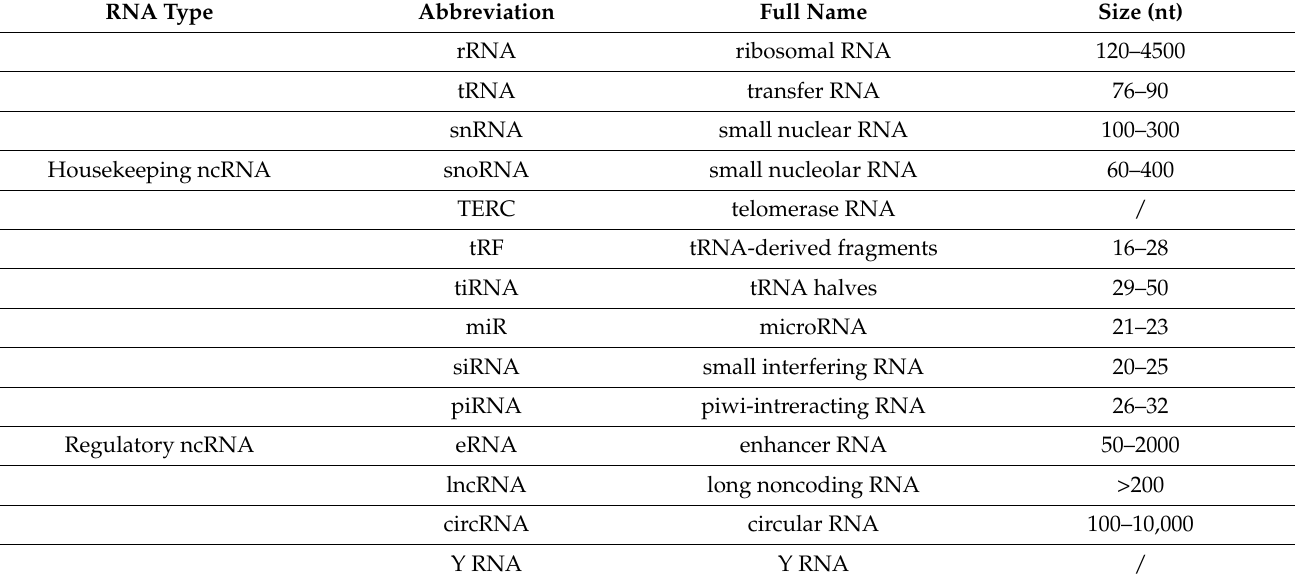
Table 1. The different types of non-coding RNAs, divided according to their function: housekeeping and regulation [1]. RNA Type